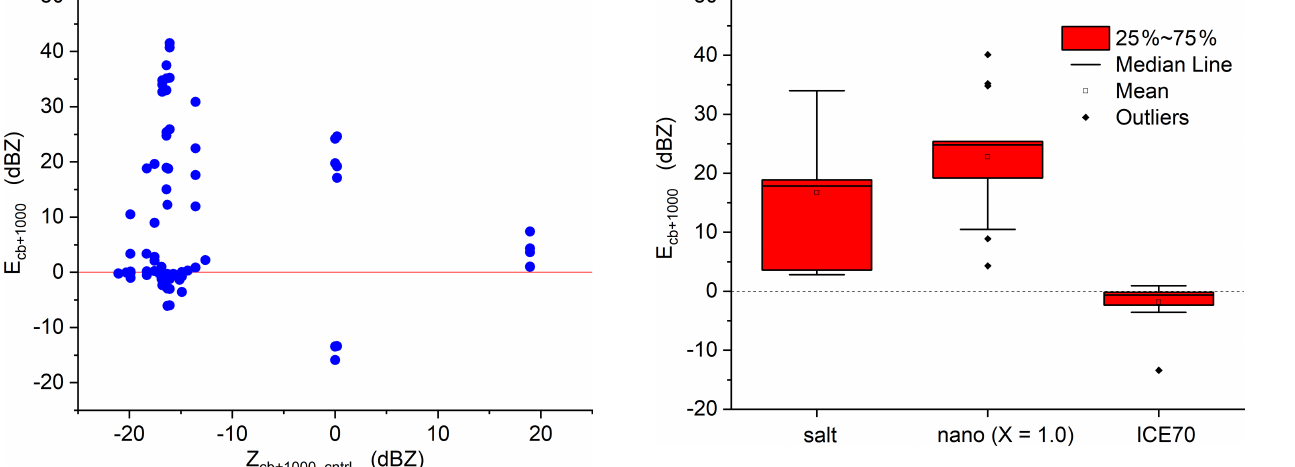
Figure 10. The box-and-whisker plots presenting the efficiency range of three different seeding materials. The box plots are evalu- ated from data representing different background aerosol types and different updraft